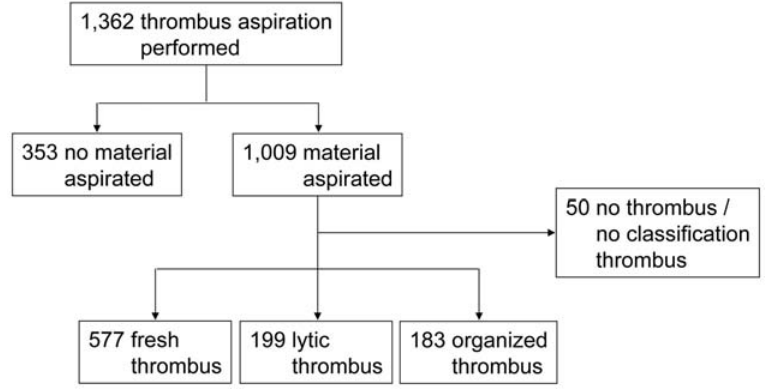
Figure 1. Study flow chart.